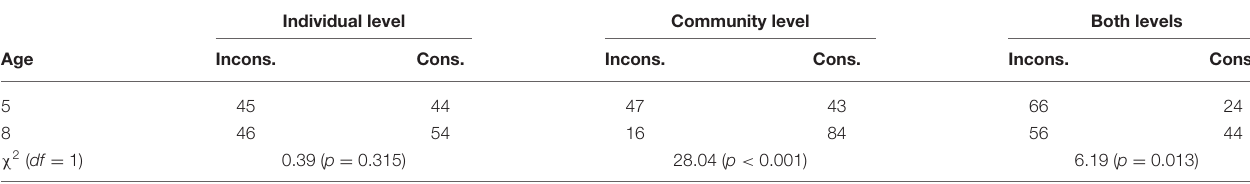
TABLE 6 | Number of children with a consistent or an inconsistent restorative orientation. Individual level Community level Both levels Incons. Cons.